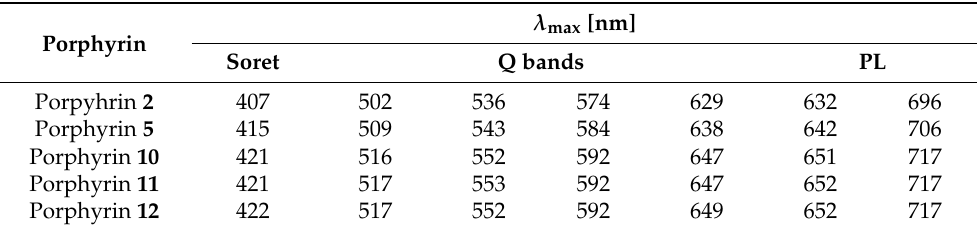
Table 1. Ultraviolet–visible (UV–vis) and photoluminescence (PL) spectral data of the different A 2 BC-type porphyrins in comparison to the starting porphyrin 2 . The porphyrins were dissolved